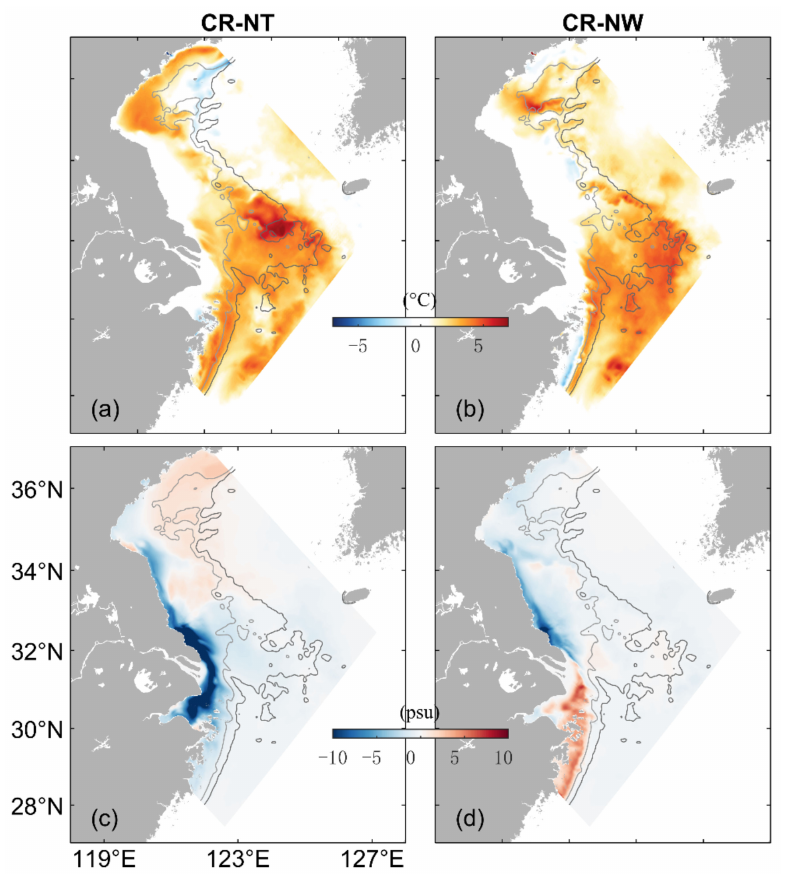
Figure 15. Same as Figure 14 except for near bottom temperature ( a , b ) and near bottom salinity ( c , d ) in August